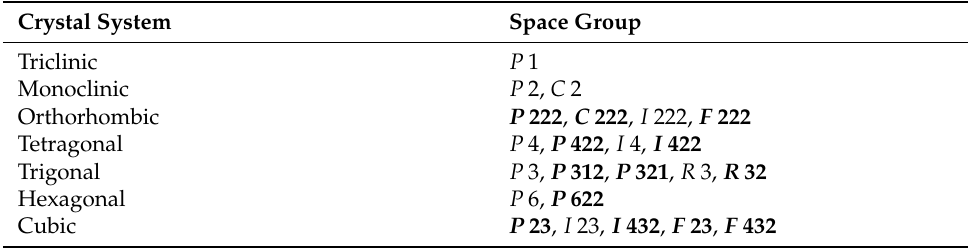
Table A1. The 23 symmorphic Sohnke groups. Printed in bold are those groups belonging to S 3 (3 spheres) topological